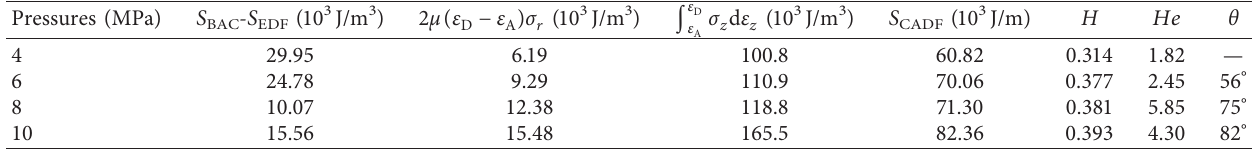
Table 1: Calculation of sandstone energy drop